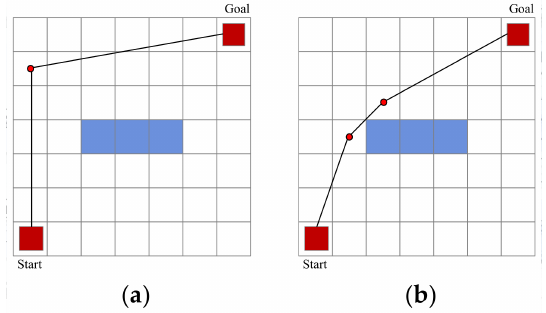
Figure 4. Detour efficiency. ( a ) Inefficient detour; ( b ) efficient